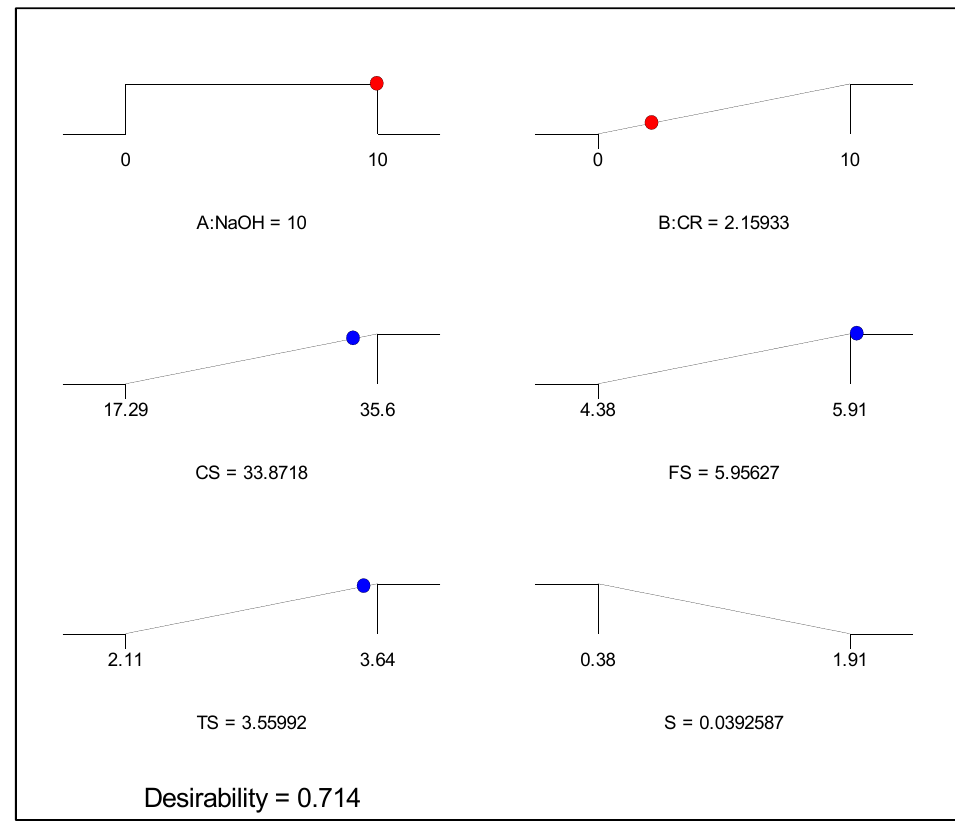
Figure 16. Optimization solution ramps.